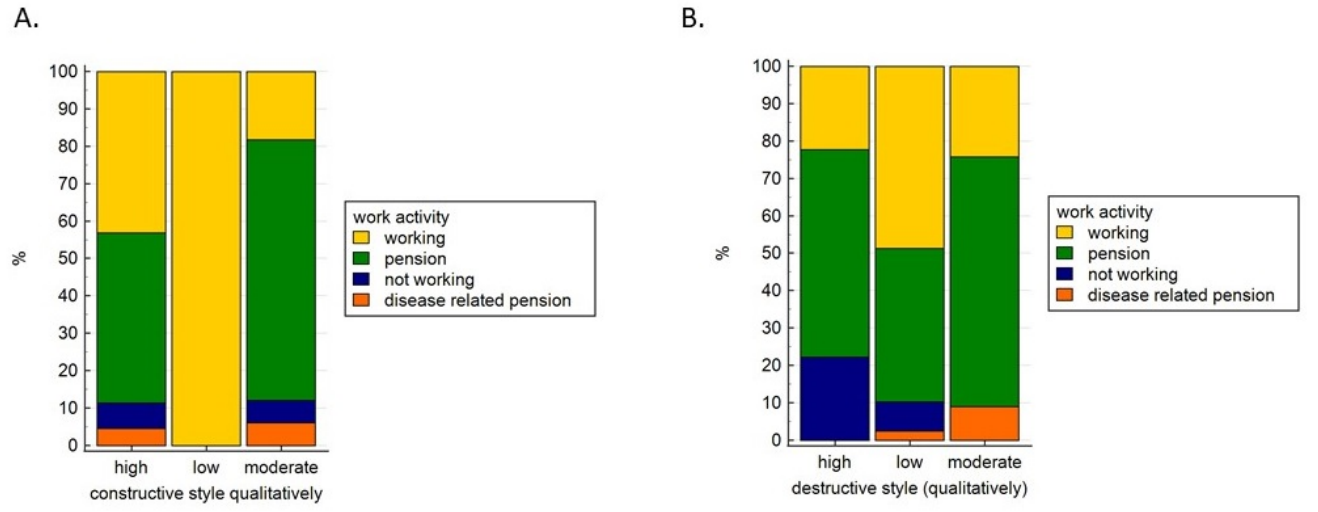
Table 5. Sociodemographic variables and level of disease acceptance.